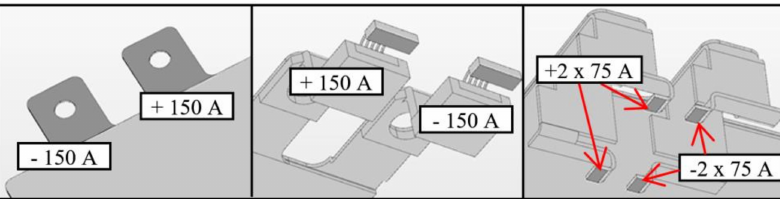
Figure 5. Power terminals geometries—Module M ( left )—Module K ( right